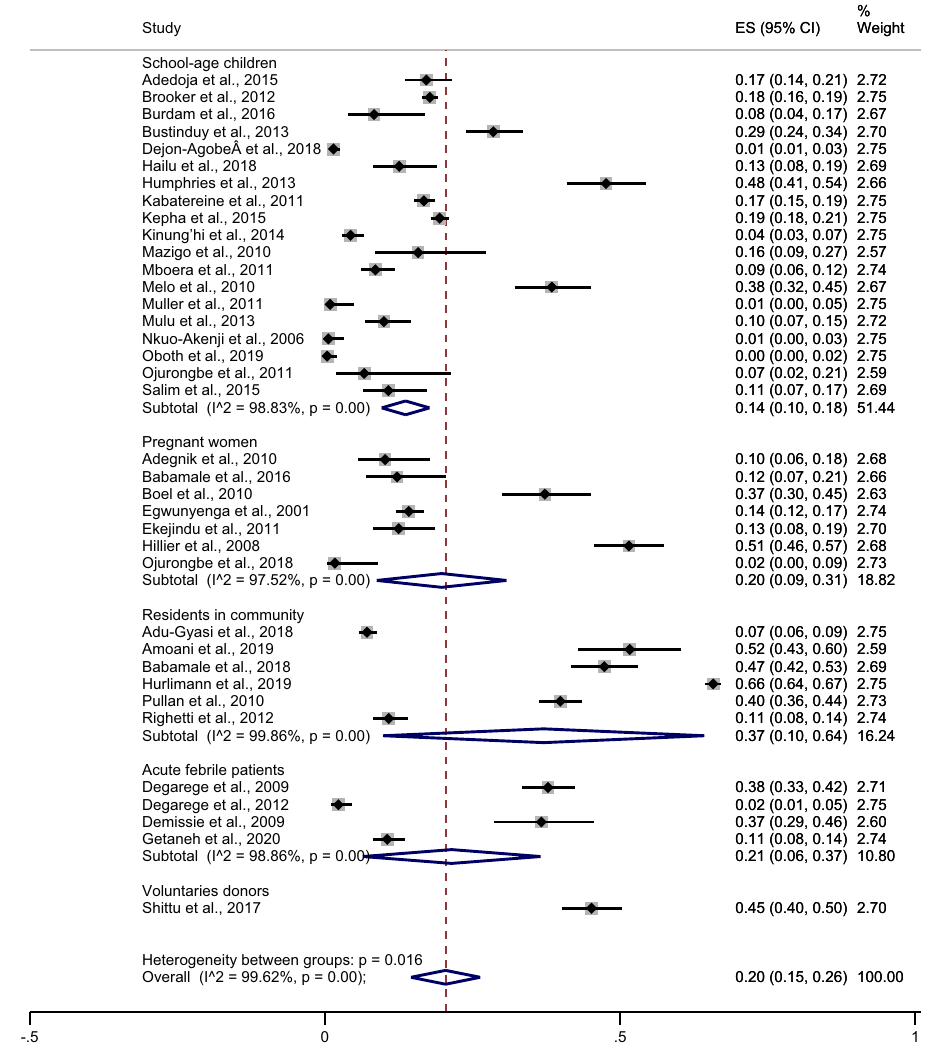
Figure 2. Pooled prevalence of Plasmodium spp. and hookworm co-infection stratified by participants. ES prevalence estimates (× 100), CI confidence